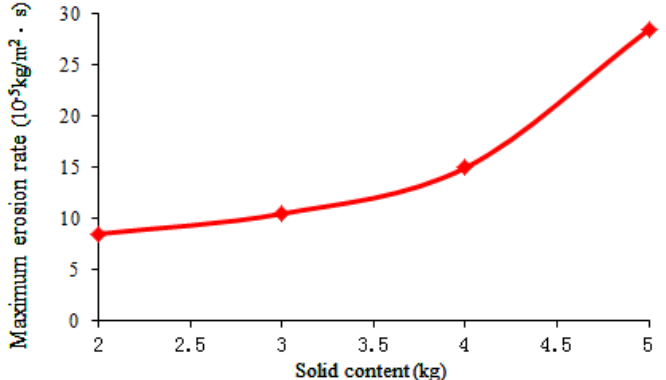
Figure 9. Curve of the maximum erosion rate versus solid content.